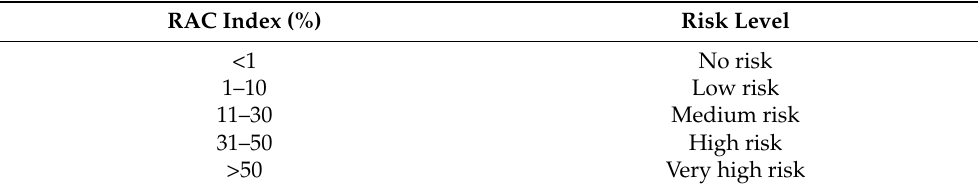
Table 2. Corresponding contamination risk level by